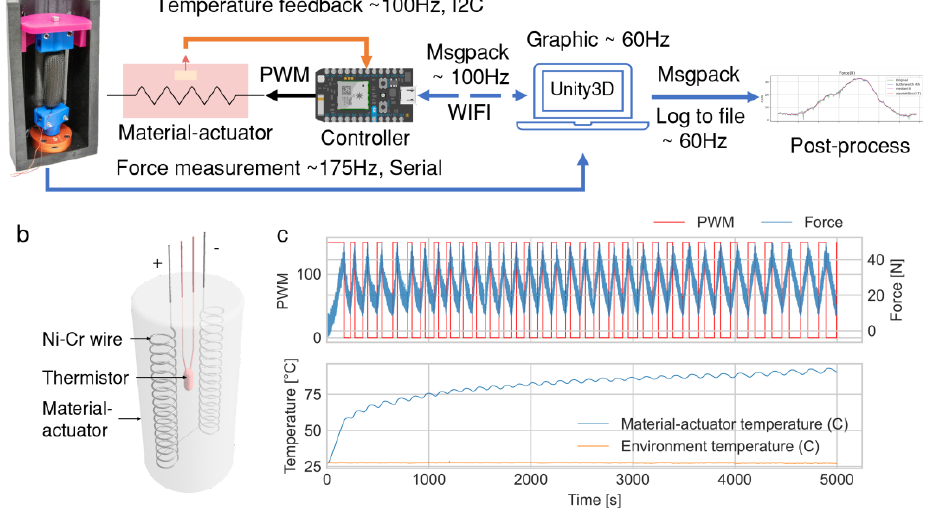
Figure 4. Multi-cyclic actuation experiment: ( a ) the testing setup (shown in detail also in Figure A1), ( b ) 3D-illustration of the silicone/ethanol material-actuator test specimen (before inserting in a braided mesh sleeving), ( c ) typical output of the experiment (fragment of results; full results may be found in Figure A3).